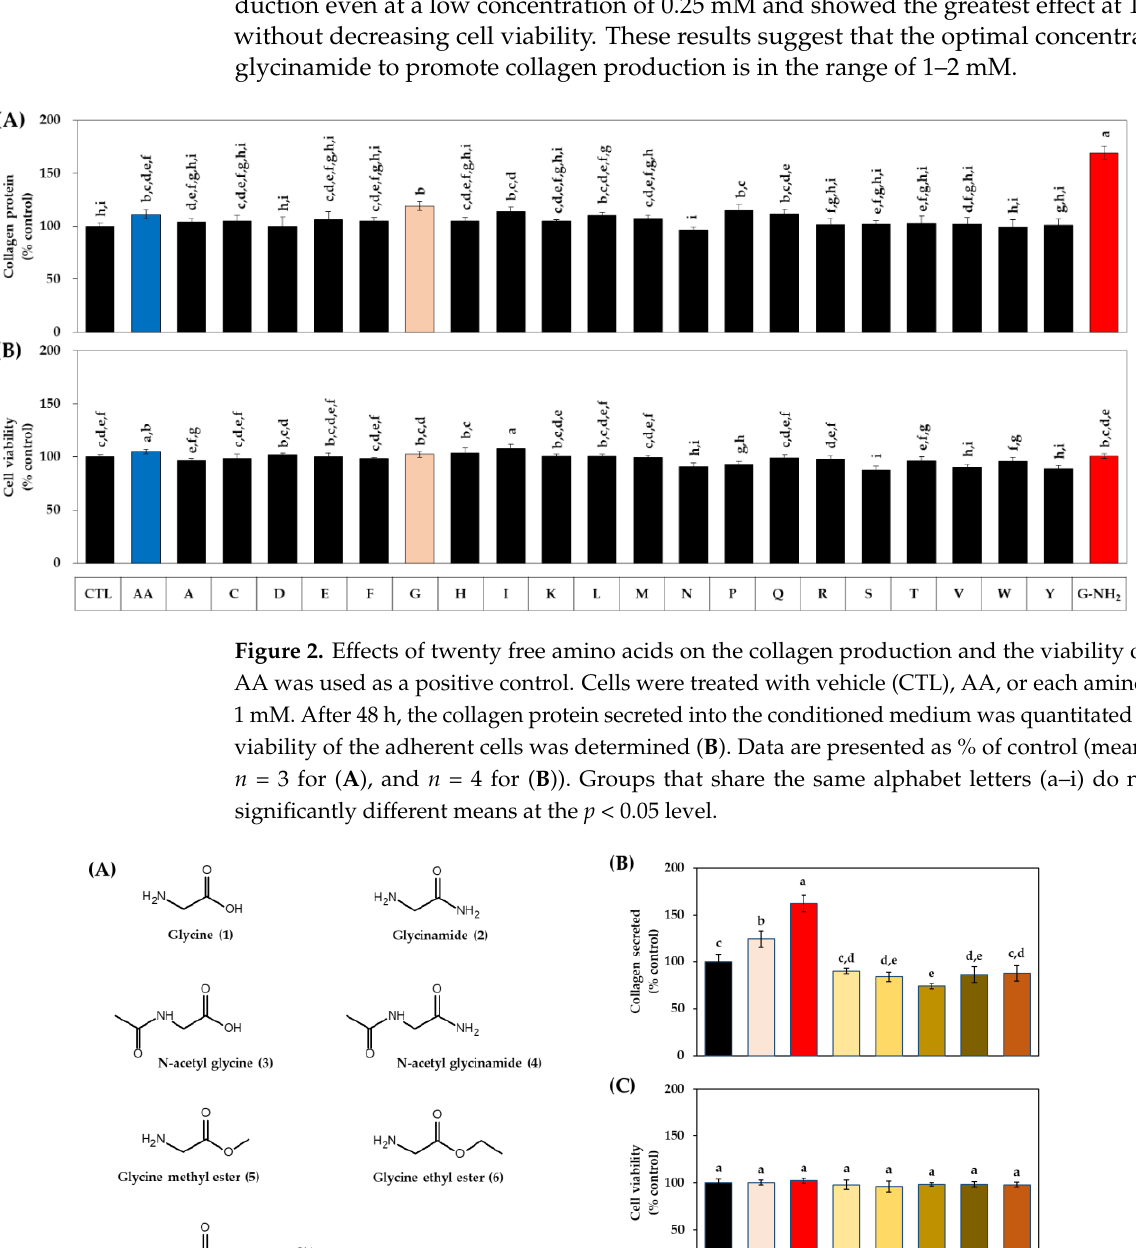
Figure 3. Effects of glycine analogs on collagen production and the viability of HDFs. Chemical structures of glycine (1), glycinamide (2), N-acetyl glycine (3), N-acetyl glycinamide (4), glycine methyl ester (5), glycine ethyl ester (6), and glycyl glycine (7) are shown ( A ). Cells were treated with vehicle (CTL) or each compound at 1 mM. After 48 h, the collagen protein secreted into the conditioned medium was quantitated ( B ). The viability of the adherent cells was determined ( C ).